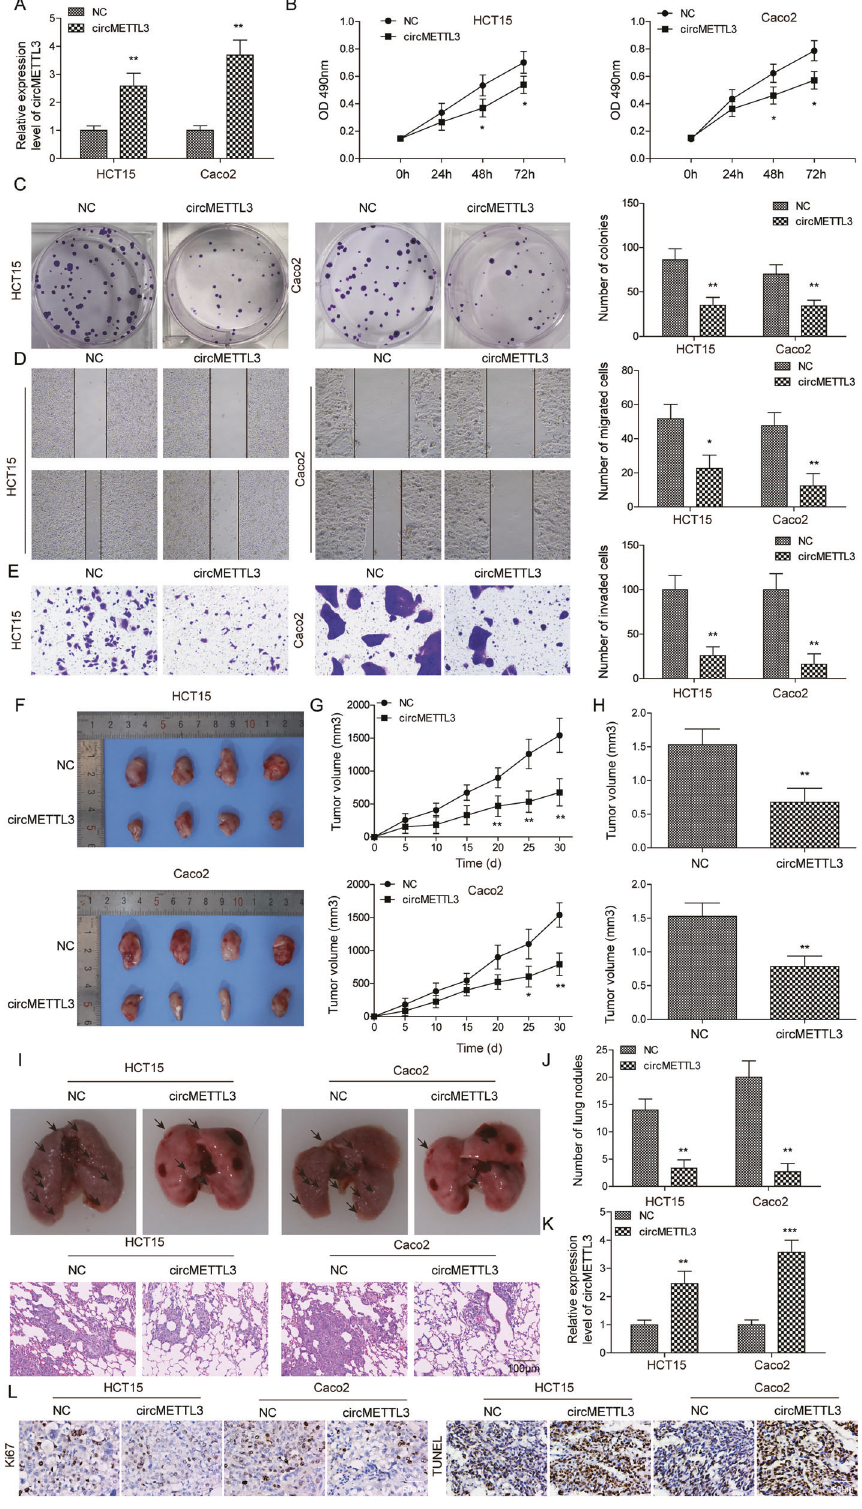
Fig. 3 Overexpression of circMETTL3 inhibited proliferation and migration of CRC cells. A Relative circMETTL3 levels in transfected Caco2 and HCT15 cells. B CCK-8 assay to measure cell viability. C Colony formation assay to assess cell proliferation. D Scratch wound assay to analyze cell migration ability. E Transwell assay to evaluate cell invasion ability. F Representative tumor images in mice bearing transfected Caco2 and HCT15 cells. G Tumor volume in each group of mice. H Tumor weight in each group of mice. I Representative lung images in each group of mice, and H&E staining to measure the number of tumor nodules in the lung from each group of mice. J Quanti fi cation of the number of tumor nodules in the lung. K qRT-PCR to measure circMETTL3 level in cancer tissues at the end. L IHC staining and TUNEL staining to analyze Ki67 expression and apoptosis of cancer cells in each group.